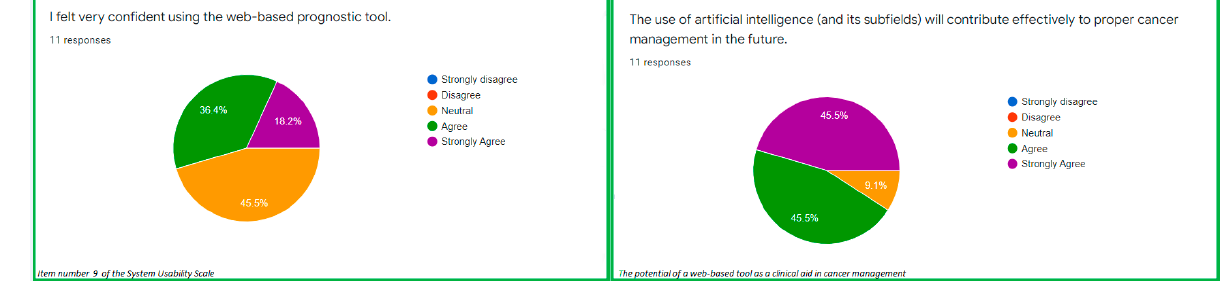
Figure 3. The potential of a web-based tool in cancer management.